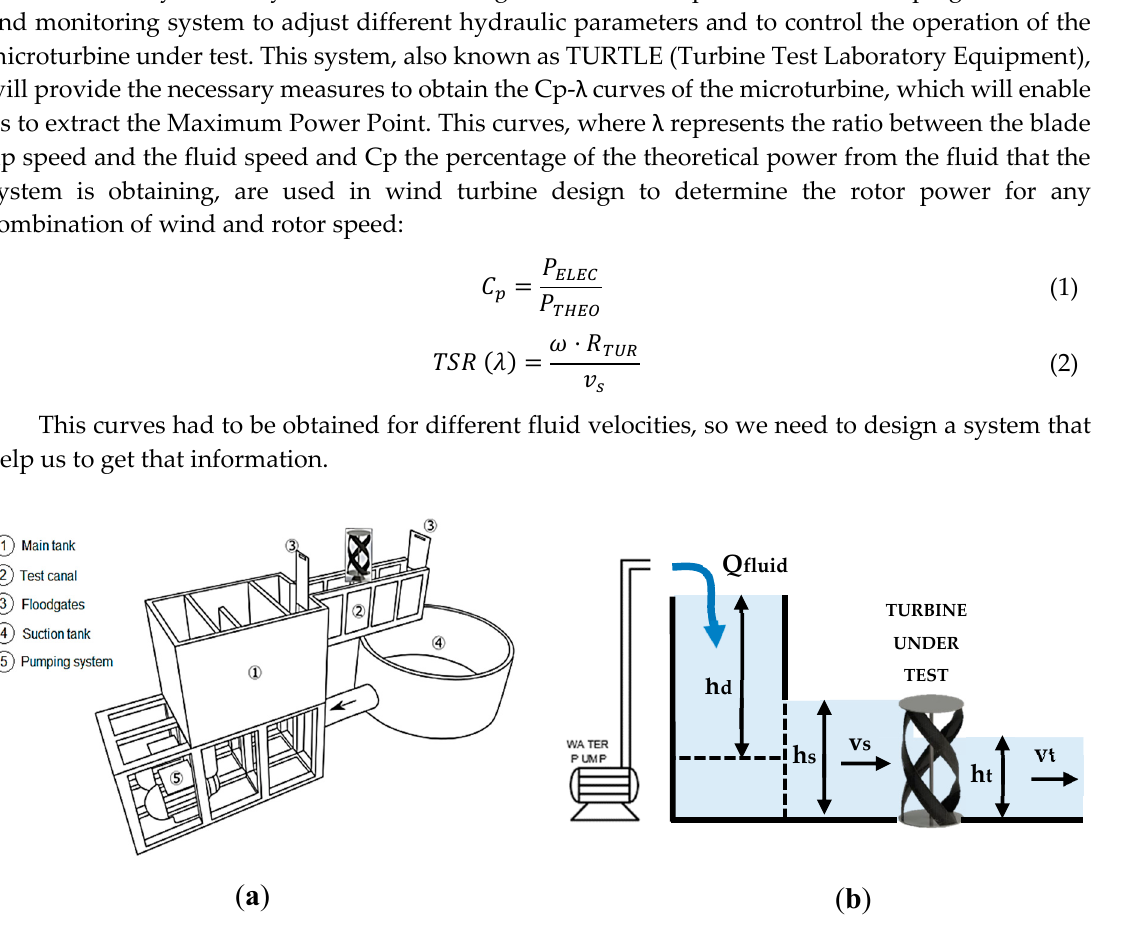
Figure 1. The test bench can be divided in two different systems: ( a ) A hydraulic system, designed to develop tests with the prototypes of microturbines; ( b ) The TURTLE System which will provide the necessary measures to obtain the Cp- λ